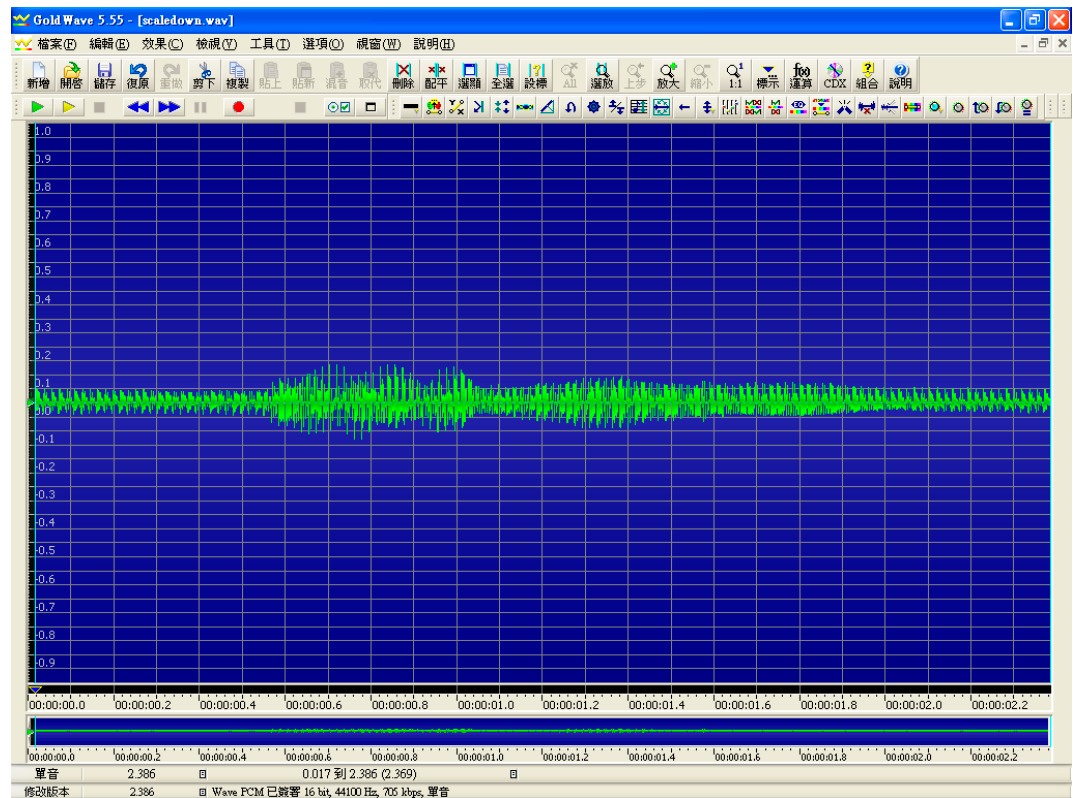
Figure 6. GoldWave acquired soundwave signals through the sound card.